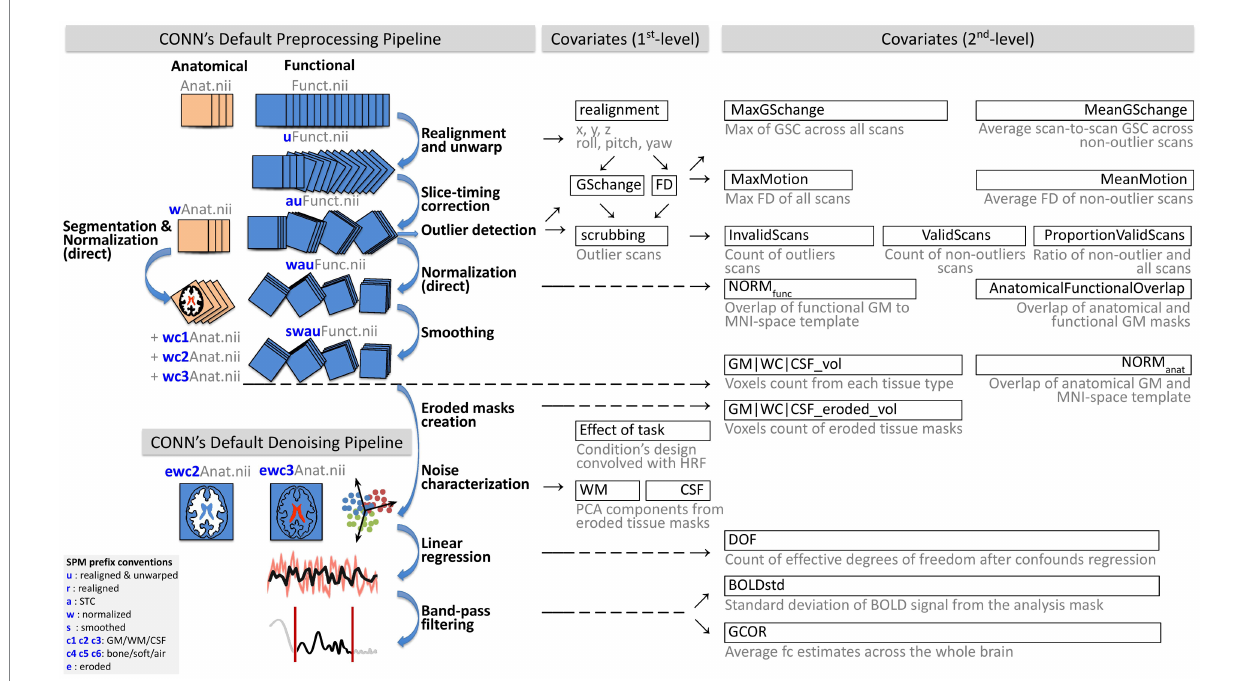
FIGURE 1 Schematic of preprocessing and denoising analysis flow and automated QC measures. The figure illustrates the CONN’s minimal default preprocessing and denoising pipelines and the automated quality control measures generated from each step. Automated QC measures were considered Covariates (1st-level) if they represented run-specific timeseries (i.e., one value per scan) or Covariates (2nd-level) if they were the collection of aggregated within- run estimates (i.e., one value per run). BOLD, blood oxygen level dependent; CSF, cerebrospinal fluid; DOF, degrees of freedom; FD, framewise displacement; GM, gray matter; GCOR, global correlation; GS, global signal; HRF, hemodynamic response function; QC, quality control; WM, white matter. This figure was adapted with permission from Nieto-Castanon (2020), Copyright © 2020 Alfonso